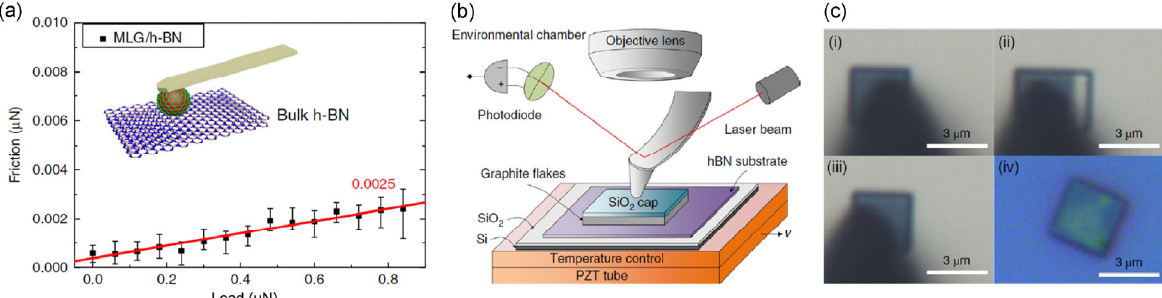
Fig. 4 (a) Friction between graphene-coated microsphere tip and h-BN substrate. The inset was the schematic view of the microsphere and substrate. Reproduced with permission from Ref. [40]. © Springer Nature, 2017. (b) Schematic diagram of the experimental set-up to measure the friction in graphite/h-BN junctions, and (c) fabrication process of the graphite/h-BN heterostructure. Reproduced with permission from Ref. [42]. © Springer Nature, 2018.